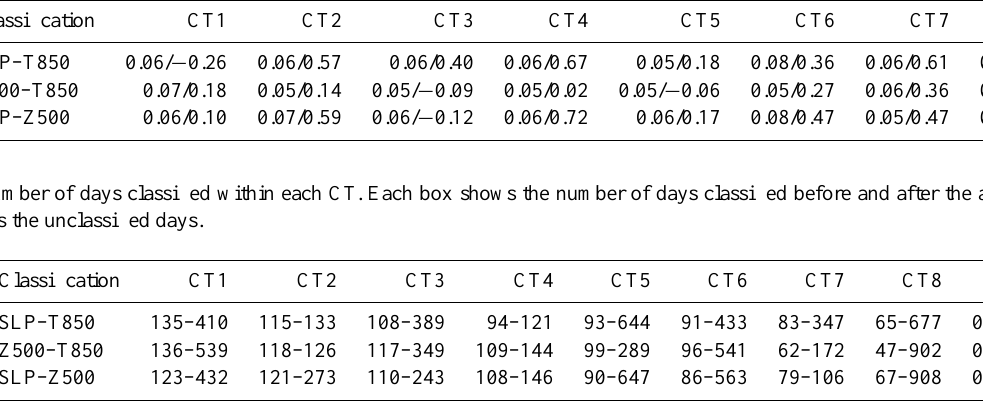
Table 6. Thresholds of the different CTs used for distance/correlation in the allocation process. Classification CT1 CT2 CT3 CT4 CT5 CT6 CT7 0.06/ − 0.26